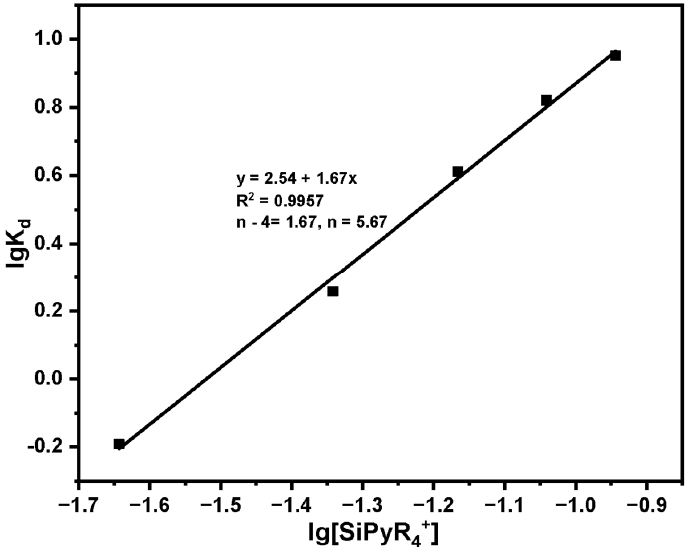
Figure 20. Fitting results of adsorption mechanism. Table 7. Adsorption mechanism experiment results.